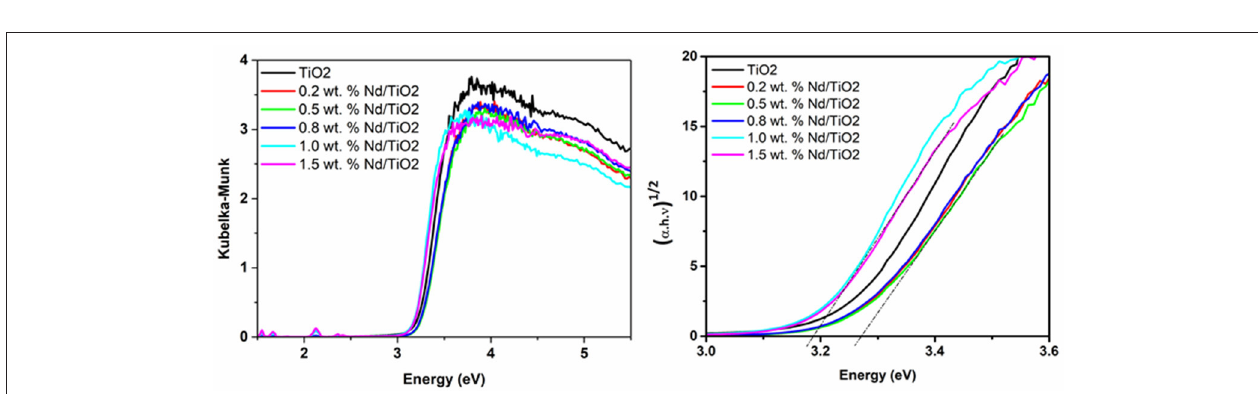
FIGURE 4 | UV-vis DRS spectra of pure TiO 2 and Nd/TiO 2 photocatalyst.